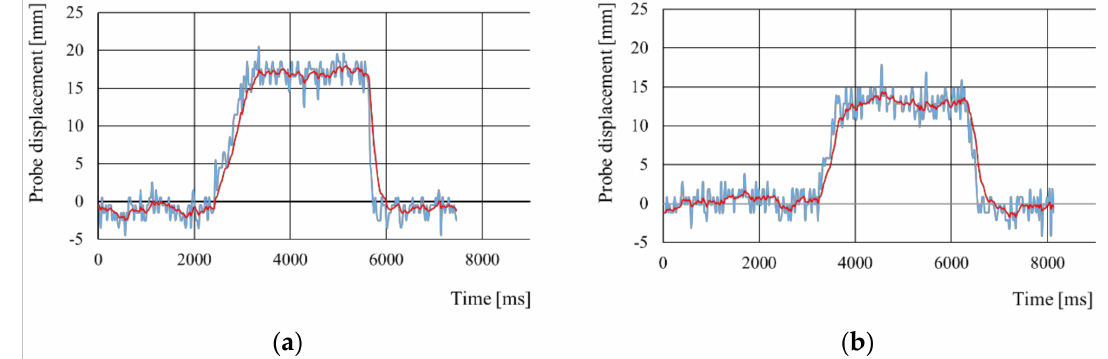
Figure 8. Example of probe displacement when measuring stiffness near left iliac bone of a participant: ( a ) before abdominal massage; ( b ) after abdominal massage. The blue line represents raw data, whereas the red line represents the filtered and smoothed